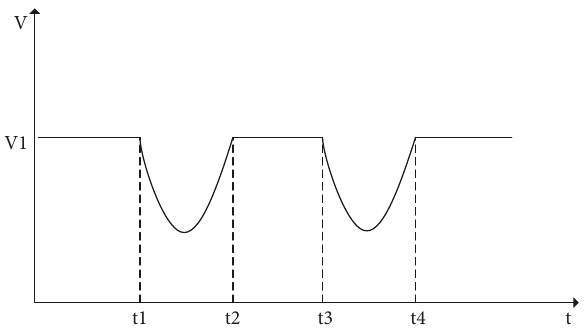
Figure 3: Variation of speed with